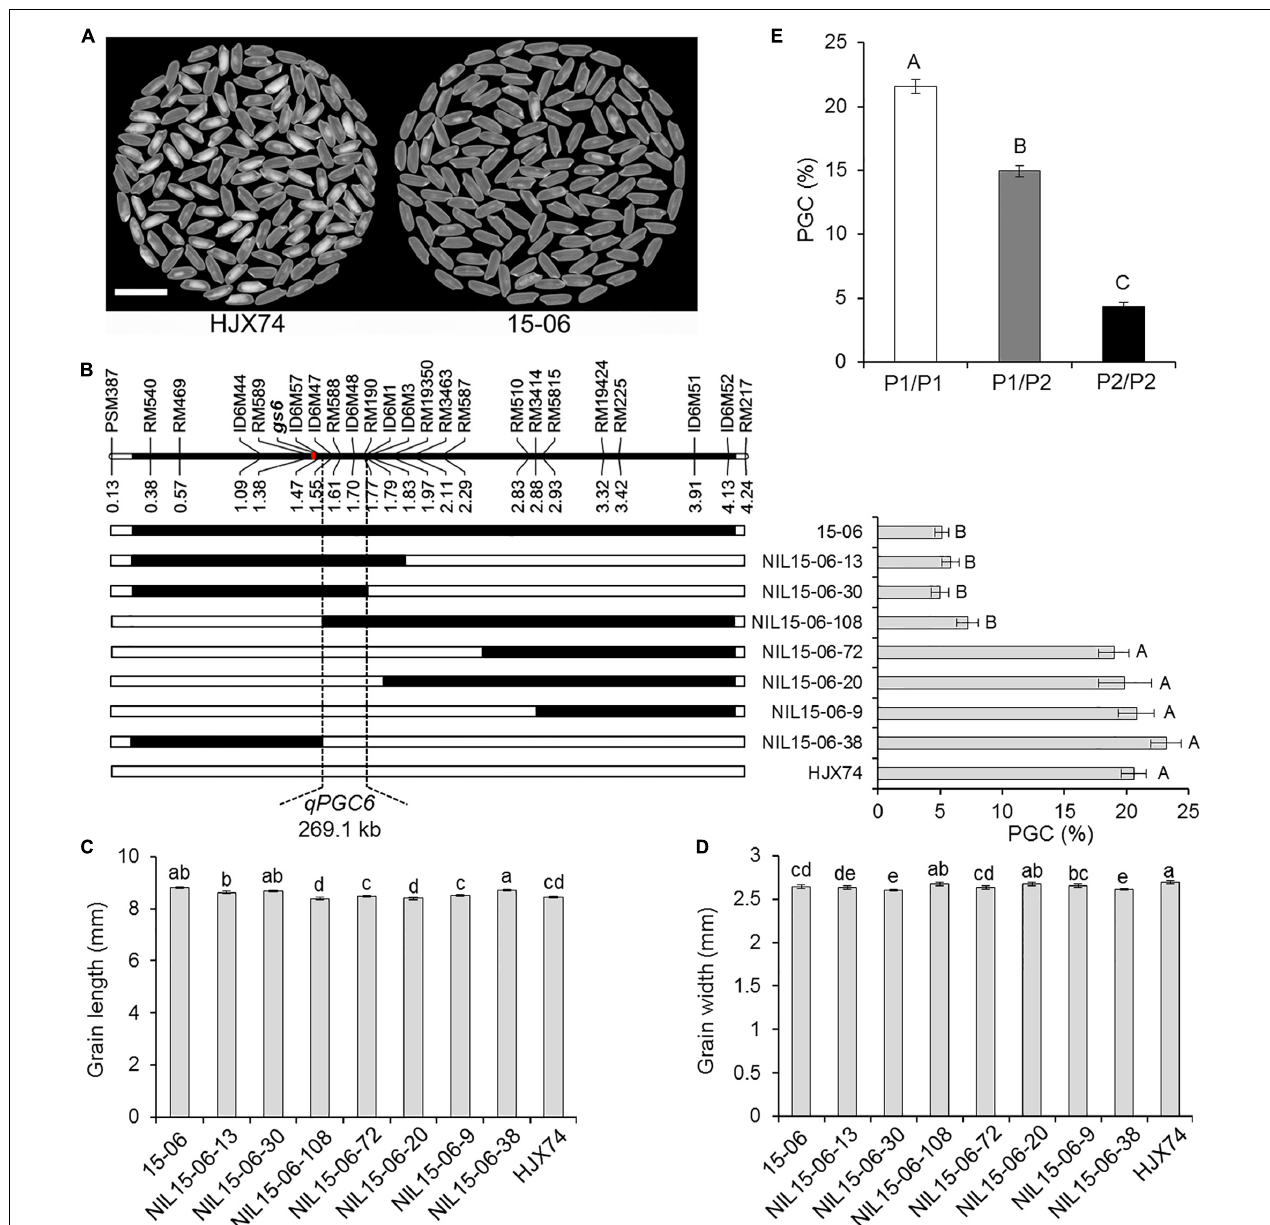
FIGURE 3 | Substitution mapping of qPGC6. (A) The appearance of milled rice of SSSL 15–06 and control HJX74. Scale bar, 1 cm. (B) Substitution mapping of qPGC6 in SSSL 15–06. The positions of markers on the chromosome are shown in physical distance (Mb). The position of gs6 gene is shown on the chromosome. Black blocks show the substitution segments from 15–06 in NILs. PGC (%) is the mean ± S.E. of two cropping seasons. Grain length (C) and width (D) of 15–06 and NILs are given as the mean ± S.E. of two cropping seasons. (E) PGC of three qPGC6 genotypes in an F 2 population. P1/P1, The genotype of qPGC6-HJX74/qPGC6-HJX74 ( n = 45); P1/P2, The genotype of qPGC6-HJX74/qPGC6-NIL ( n = 84); P2/P2, The genotype of qPGC6-NIL/qPGC6-NIL ( n = 41). Different uppercase letters and lowercase letters indicate significant differences at the 0.05 level and 0.01 level,